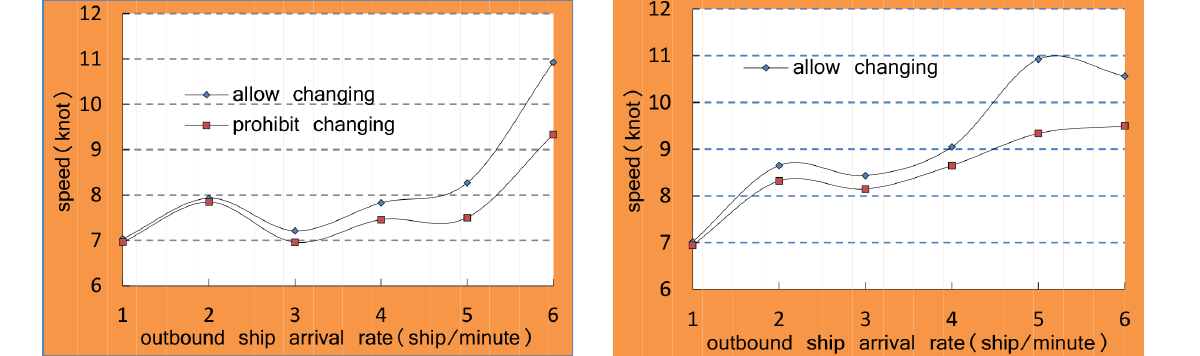
Figure 24. Average speed of waterway system and ship arrival rate as a function (inbound ship arrival rate = 5)